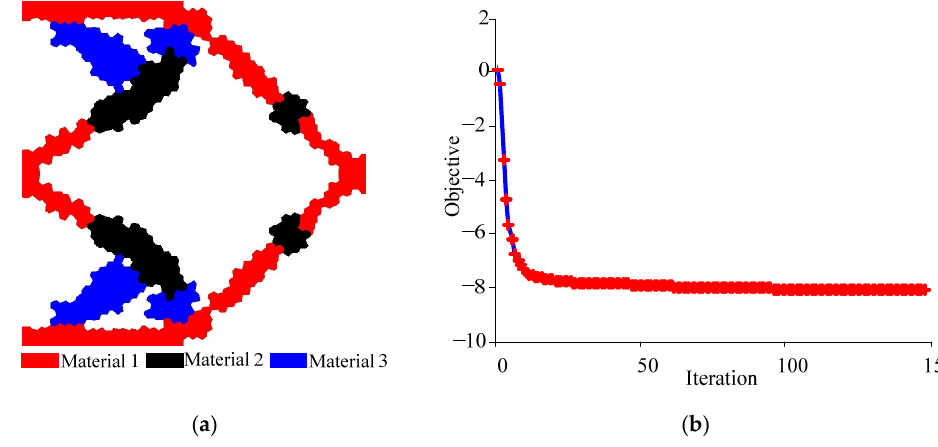
Figure 6. Optimization results of case 2: ( a ) Identifed topologies; ( b ) convergence plot.